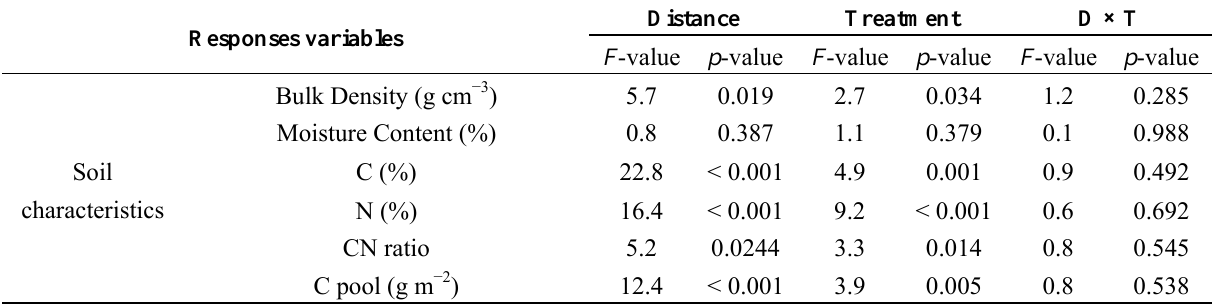
Table 1. Summary analysis of covariance (ANCOVA) for the effect of restoration treatments (df = 4) and distance (df = 1) from the trunk and interaction (df = 4) between treatment and distance on soil and vegetation characteristics for 36 longleaf pine (